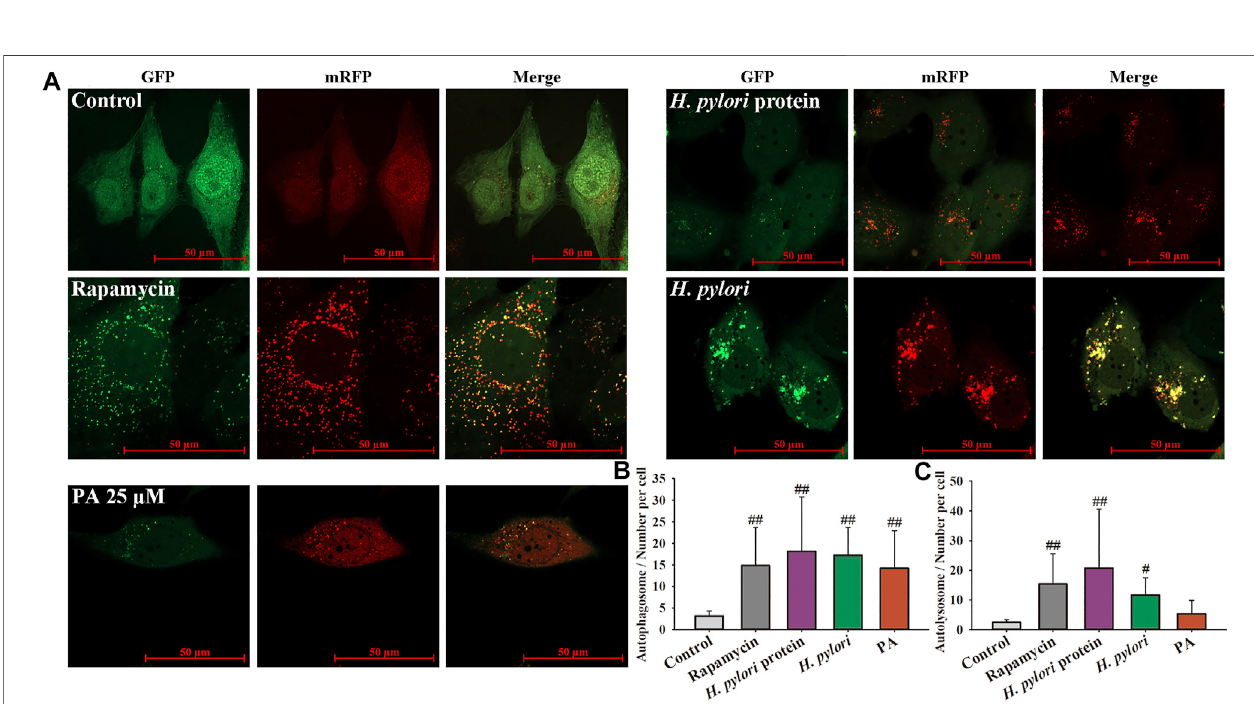
FIGURE 5 | H. pylori infection induced xenophagy in GES-1 cells. mRFP-LC3-GFP adenovirus was adopted to label autophagosomes and autolysosomes. GFP fl uorescence isquenched when autophagosomes fuse with lysosomes. Merged yellow dots indicate autophagosomes, and autolysosome numbers were calculated as number of red dots minus number of yellow dots. (A) Representative images of the xenophagy state after different treatments for 12 h. (B) Quantitative results of autophagosomes. (C) Quantitative results of autolysosomes. # p < 0.05, ## p < 0.01, compared with the control group, n (cid:2) 4.